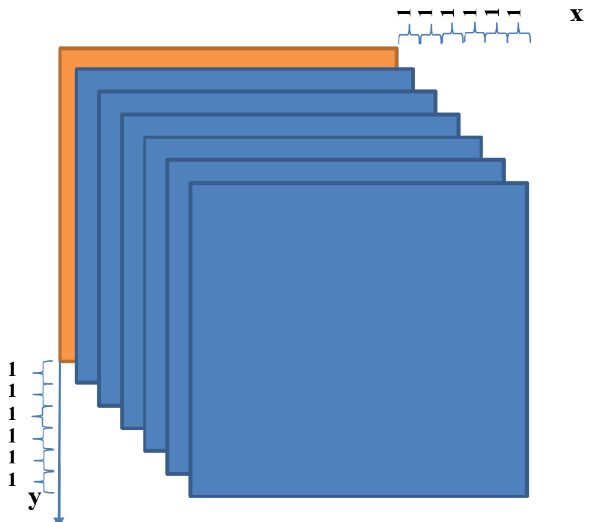
Figure 7. Quantitative fusion result comparison between SRE-ResNet and ResNet for Dataset II. ( a ) SRE-ResNet, ( b ) SRE-ResNet.